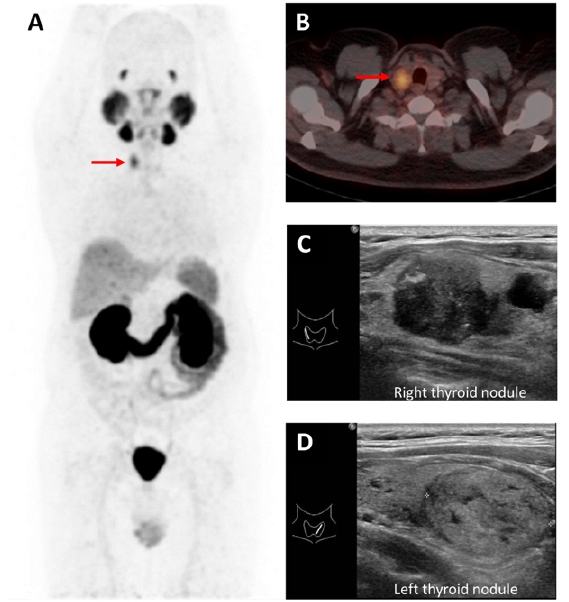
Figure 4. A 59-year-old man with prostate cancer post-radical prostatectomy. [ 68 Ga]Ga-PSMA-11 MIP skull-to-mid-thigh PET ( A ) and axial fused PET/CT ( B ) images revealed a PSMA-avid right thyroid nodule (red arrow) despite bilateral thyroid nodules. The ultrasound images ( C , D ) revealed right and left thyroid nodules, respectively. He subsequently underwent thyroid surgery with confirmed PTC in the right thyroid nodule and benign left thyroid nodule.